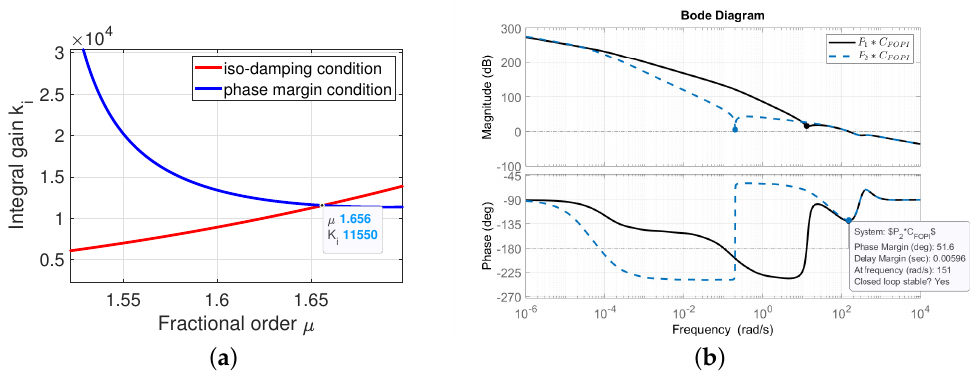
Figure 7. ( a ) The cross-section point of the phase margin and iso-damping criteria; ( b ) a Bode diagram of the open loop system in the two extreme cases.